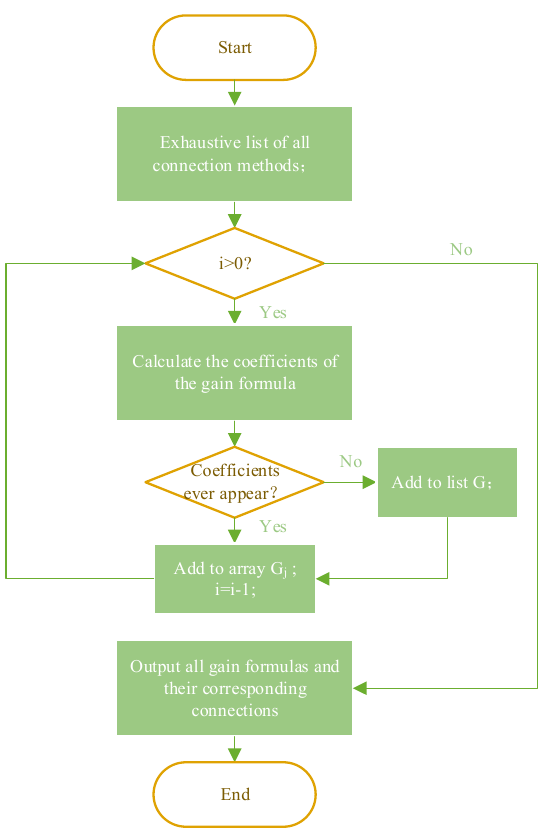
Figure 1. Flowchart of the developed program to calculate all different forms of gain.